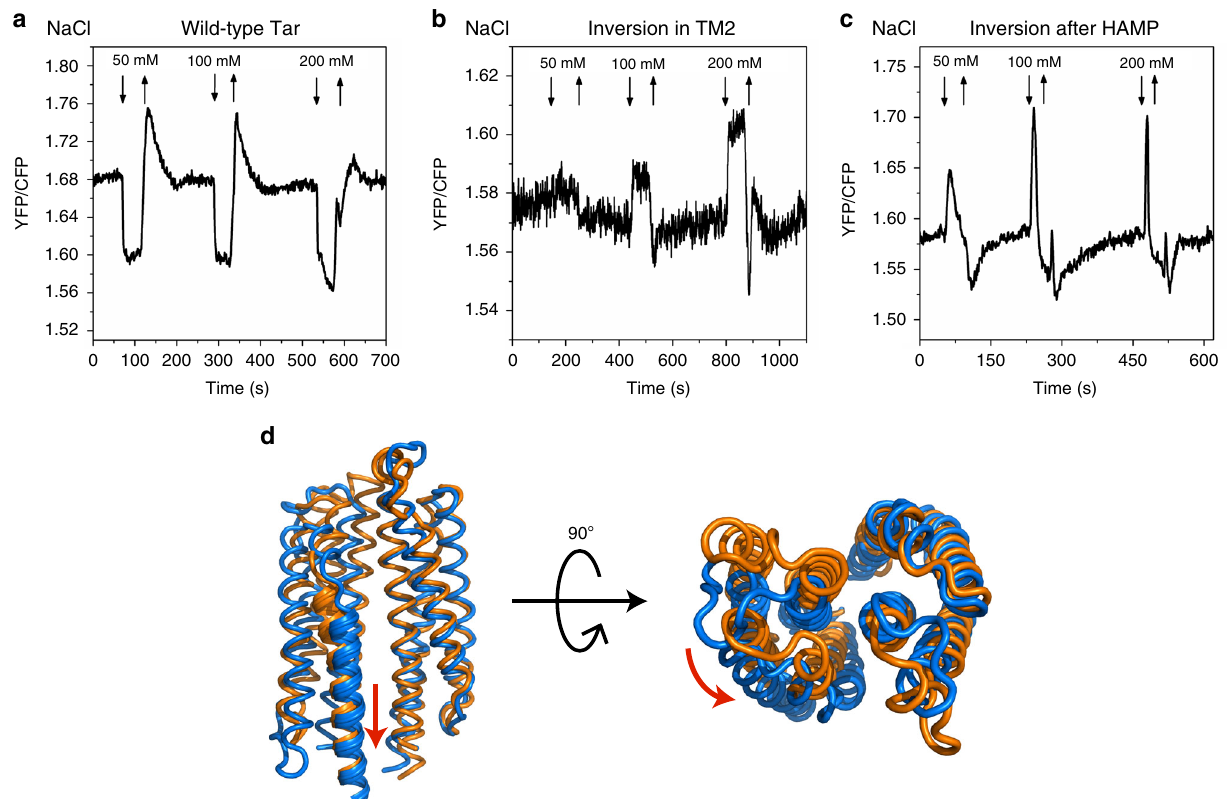
Fig. 5 Responses of the wild-type and mutant Tar to NaCl. a – c FRET response of buffer-adapted E. coli CheR + CheB + strain VS181 expressing the wild-type Tar, Tar TM2 + 2I (inversion in TM2), and Tar HAMP_GVPQM (inversion after HAMP) as a sole receptor to a stepwise addition (down arrow) and subsequent removal (up arrow) of the indicated concentrations of NaCl. d Representative conformations of Tar periplasmic domain, simulated at 0 (orange) or 50 mM (blue) NaCl, with the side and top view. The structures were aligned with one monomer of the dimer. The red arrows describe the inward sliding of the α 4 relative to α 1 helix and rotation of one monomer relative to the other at 50 mM NaCl. Residues 155 – 181 of the periplasmic domain are highlighted to indicate the inward movement of α 4